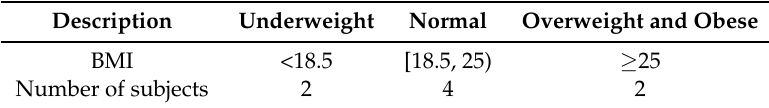
Table 4. BMI distribution of the subjects participating to the